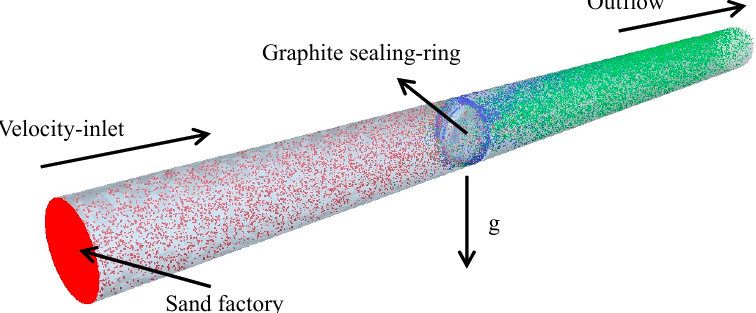
Figure 6. Schematic diagram of fluid domain, where the velocity of the red particle is greater than the velocity of the green particle, while the velocity of the green particle is greater than the velocity of the blue particle.